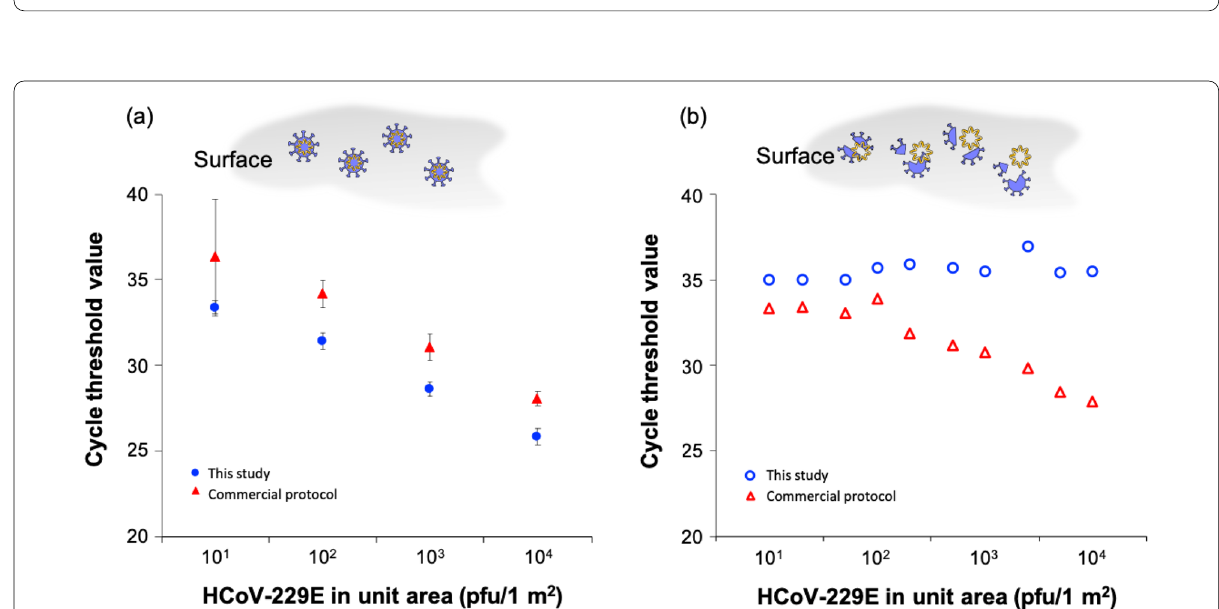
Fig. 4 RT‑qPCR results for various HCoV‑229E solution amounts using the new sample preparation protocol and current commercial protocol a on the normal test surface and b a test surface disinfected by